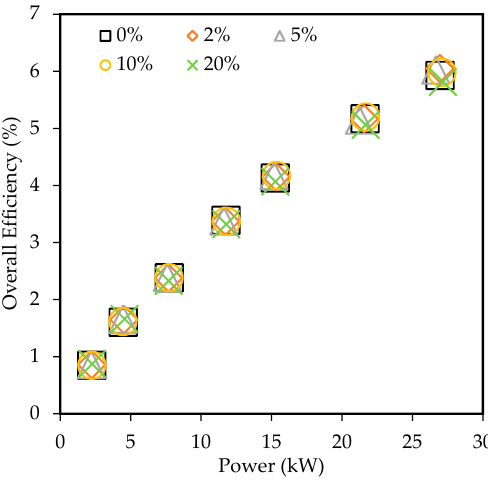
Figure 8. Variations in thermal efficiency of tested fuels.